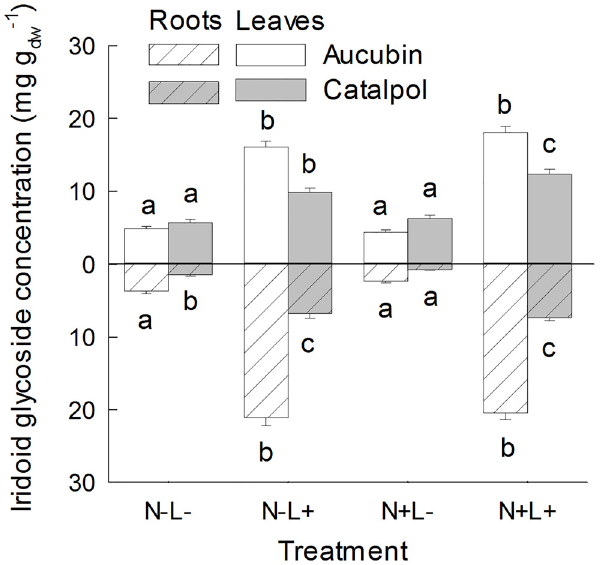
Fig 1. Aucubin and catalpol concentrations in leaves and roots of Plantago lanceolata . Plants were grown at different light and nutrient availability (N-: low nutrient, N+: high nutrient, L-: low light, L+: high light). Values are means across all plants per treatment (+ 1 SE). Results of Tukey`s test applied to test for significant differences between different light x nutrient treatments are indicated with letters.